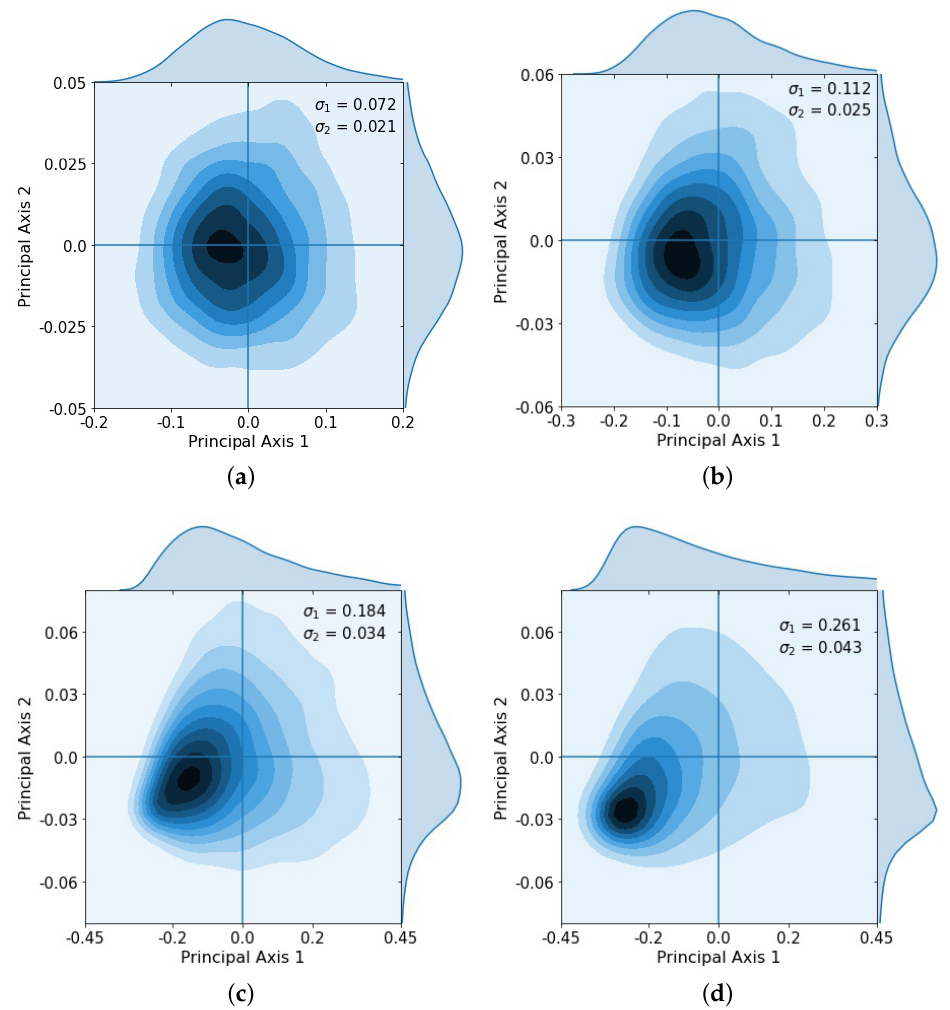
Figure 4. Kernel density estimation showing distribution after successive loops and singular values σ 1 , σ 2 . Gaussian spread starts to break down after loops 3 and 4 as some tumors began to saturate. ( a ) Loop 2, σ 1 = 0.072, σ 2 = 0.021; ( b ) Loop 3, σ 1 = 0.112, σ 2 = 0.025; ( c ) Loop 4, σ 1 = 0.184, σ 2 = 0.034; ( d ) Loop 5, σ 1 = 0.261, σ 2 =